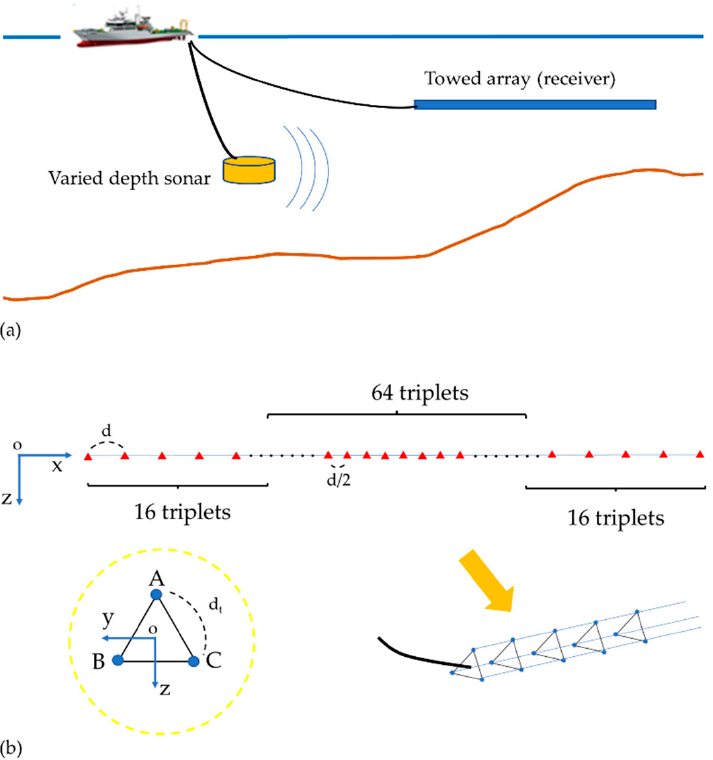
Figure 3. ( a ) Experimental setup of source and receiver. ( b ) Schematic of a triplet towed array used in the experiment.